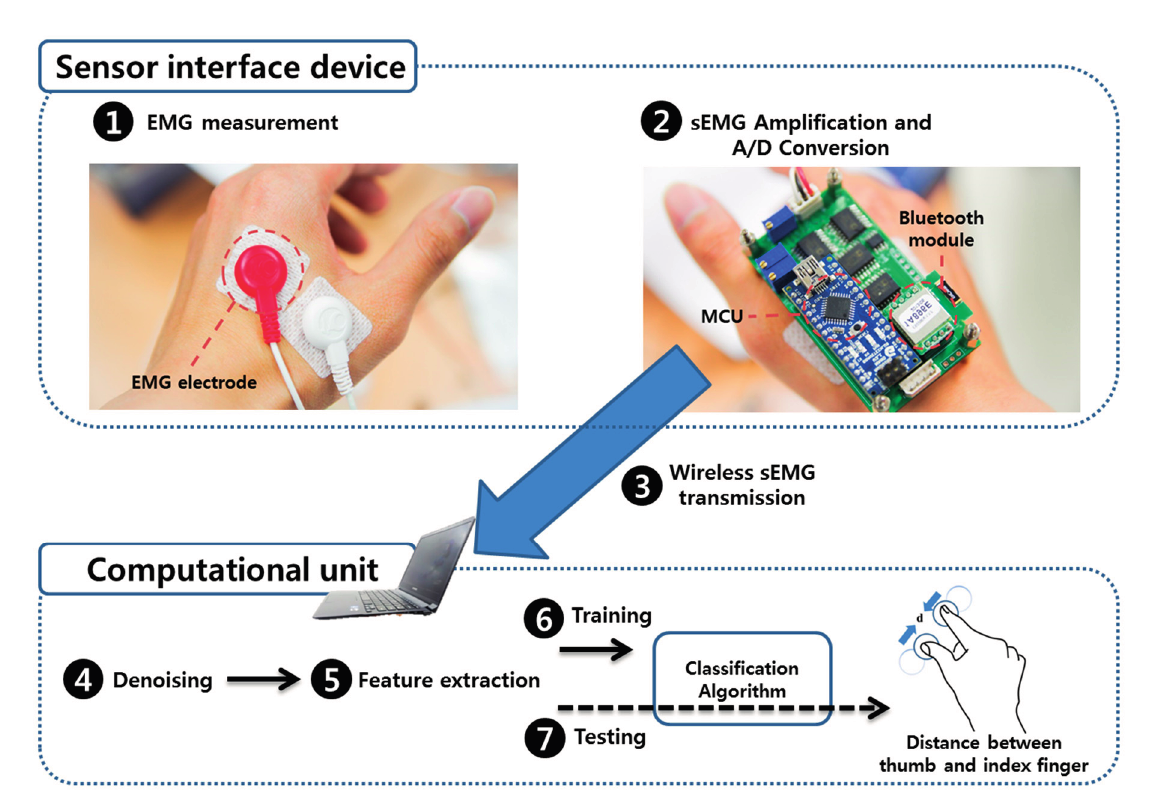
Figure 2. System configuration for detecting pinch-to-zoom gesture in real-time. The total system consists of sensor interface device and computational unit parts. In sensor interface device, EMG was recorded from first dorsal interosseous muscle and transmitted to computational unit parts. In computational unit, feature was extracted from sEMG and